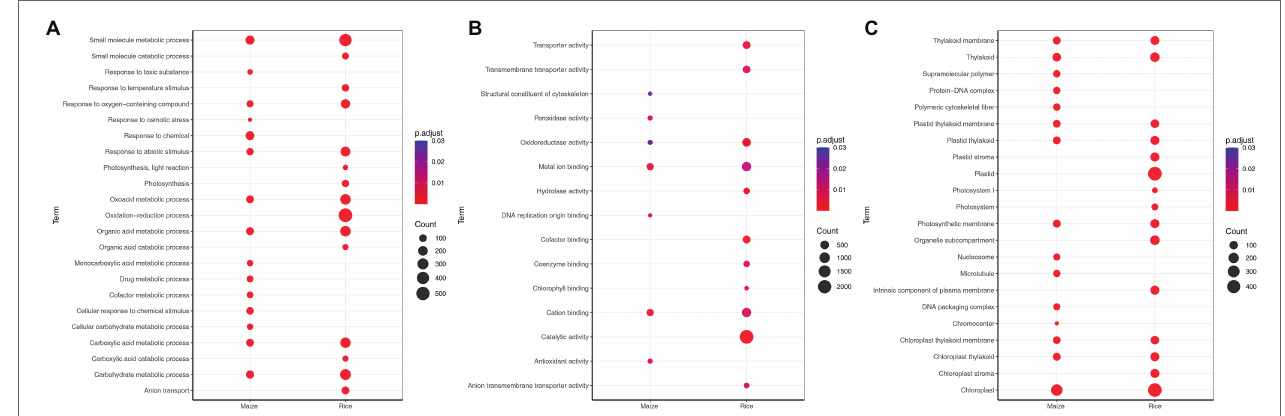
FIGURE 2 | Gene ontology (GO) enrichment analysis of differentially expressed genes (DEGs) for maize ( Zea mays ) and rice ( Oryza sativa L.), which shows the GO terms (adjusted p < 0.05) of biological processes (A) , molecular functions (B) , and cellular components (C) identified using g: Profiler. The size of the dot is based on the gene count enriched, and the color of the dot presents the terms enrichment